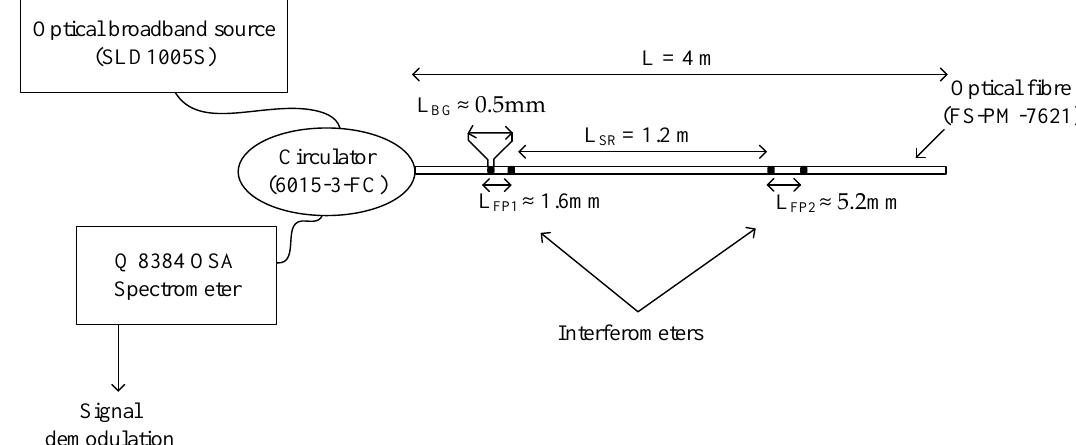
Figure 1. Optical system formed by two interferometers.